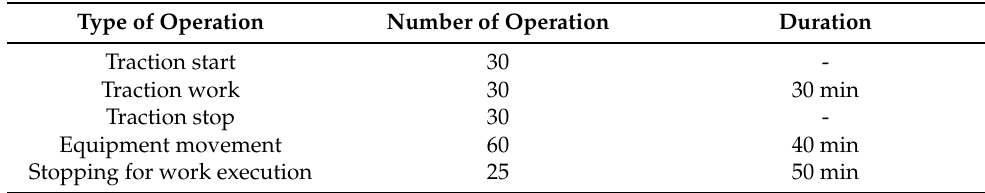
Table 2. APLA100-E working cycle